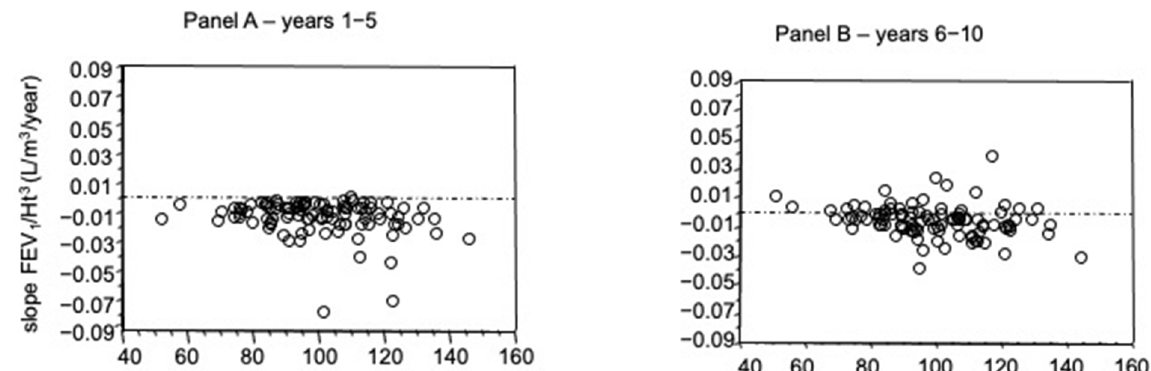
Figure 3. Relationships between slope values of relationships between height-adjusted FEV 1 and time (L/m 3 /year) for years 1–5 ( Panel A ) and for years 6–10 ( Panel B ) and FEV 1 at enrolment (% of predicted). Both correlations were significant ( p = 0.02 and p = 0.01, respectively, Spearman Rank Correlation).